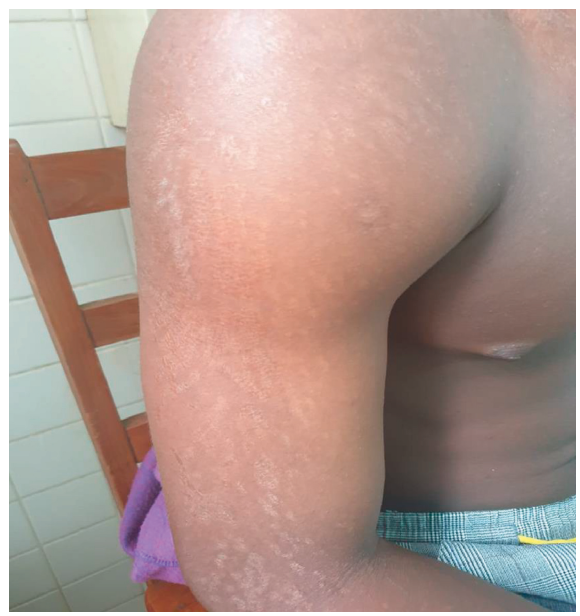
Figure 2: Pityriasis versicolor (six weeks after itraconazole